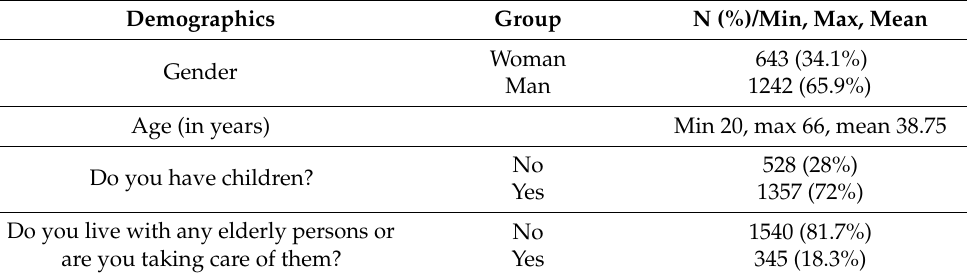
Table 2. Demographic